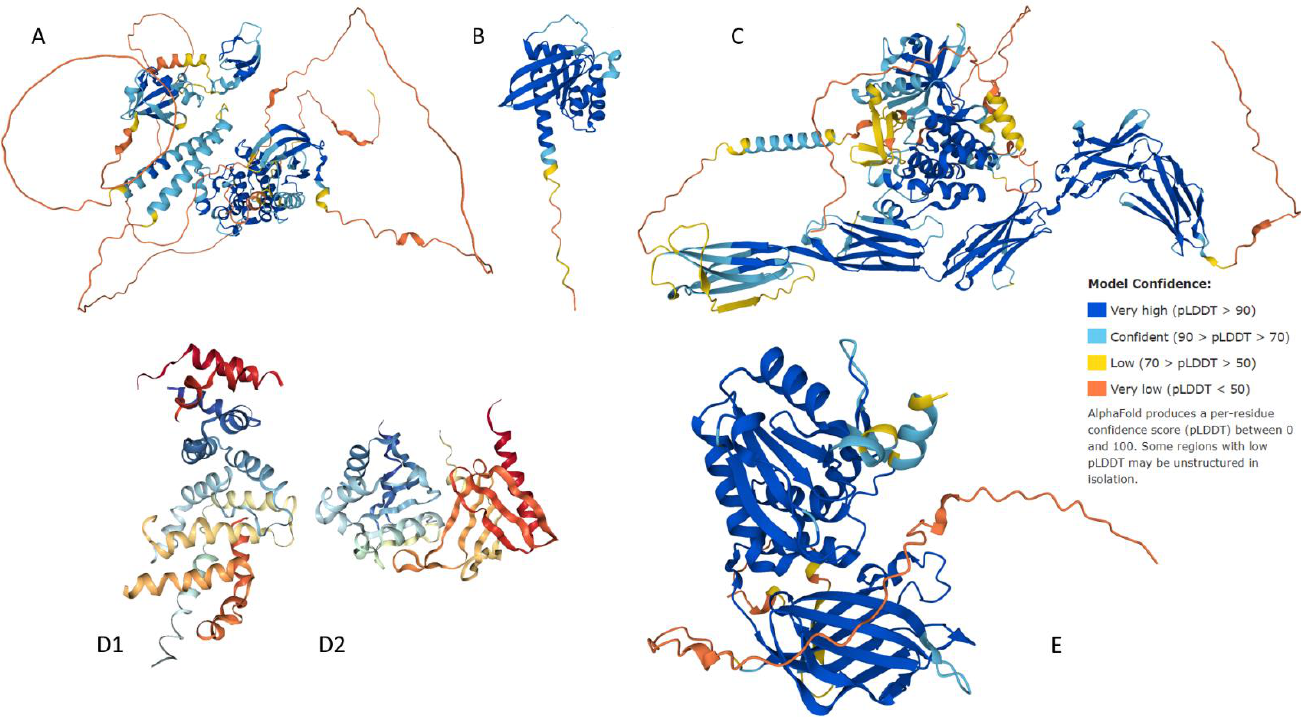
Figure 4. Universal Protein Resource (UniProt) structural output for human ( A ) BRAF, ( B ) NRAS, ( C ) c-KIT, ( D1 , D2 ) NF1, and ( E ) PTEN. Structures for BRAF, NRAS, c-KIT, and PTEN were generated by AlphaFold2, whereas structure of human NF1 is presented by X-ray crystal structures of its two domains from the protein data bank. Confidence of models generated by AlphaFold2 is color coded (see legend in the figure).